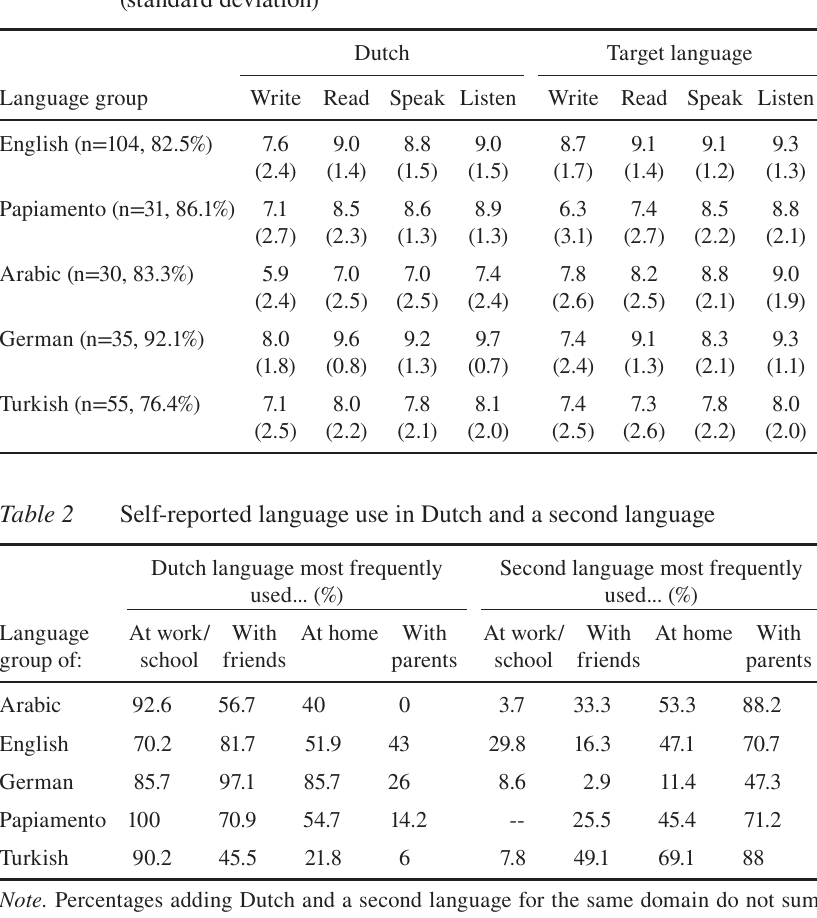
Mean self-reported proficiency in Dutch and target languages